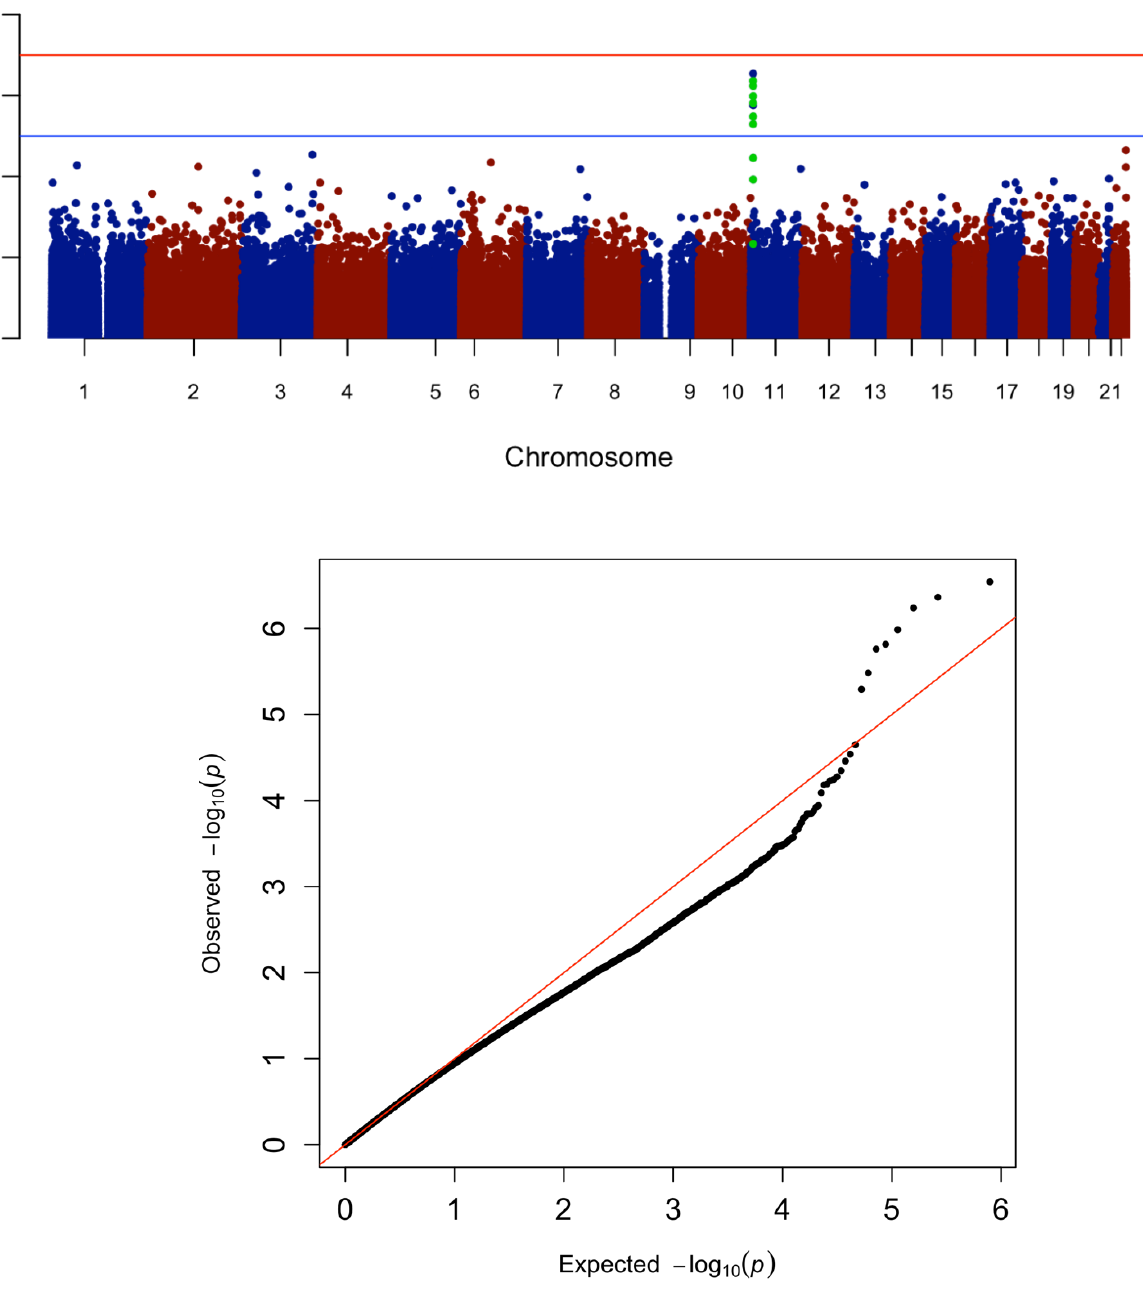
Figure 2. Manhattan & QQ Plot for RWT in HyperGEN. CpG sites in the DNHD1 DMR are highlighted in green. Lambda with genomic control for QQ plot = 0.998.